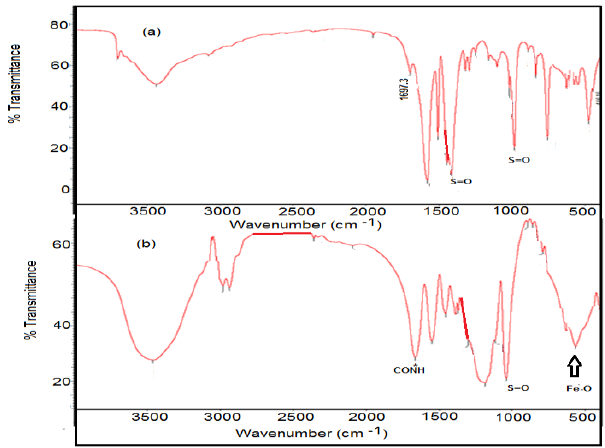
Figure 2. Fourier transform infrared (FTIR) spectra of ( a ) VS/Na-AMPS and ( b ) VS/AMPS · Fe 3 O 4